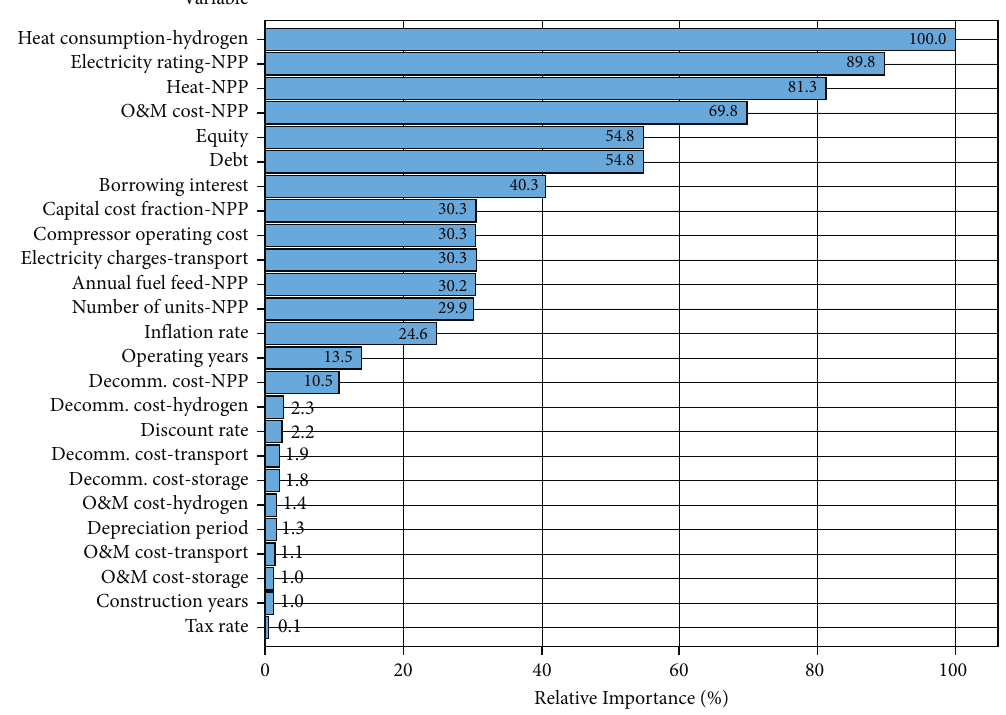
Figure 3: Relative importance of input parameters for nuclear hydrogen economic